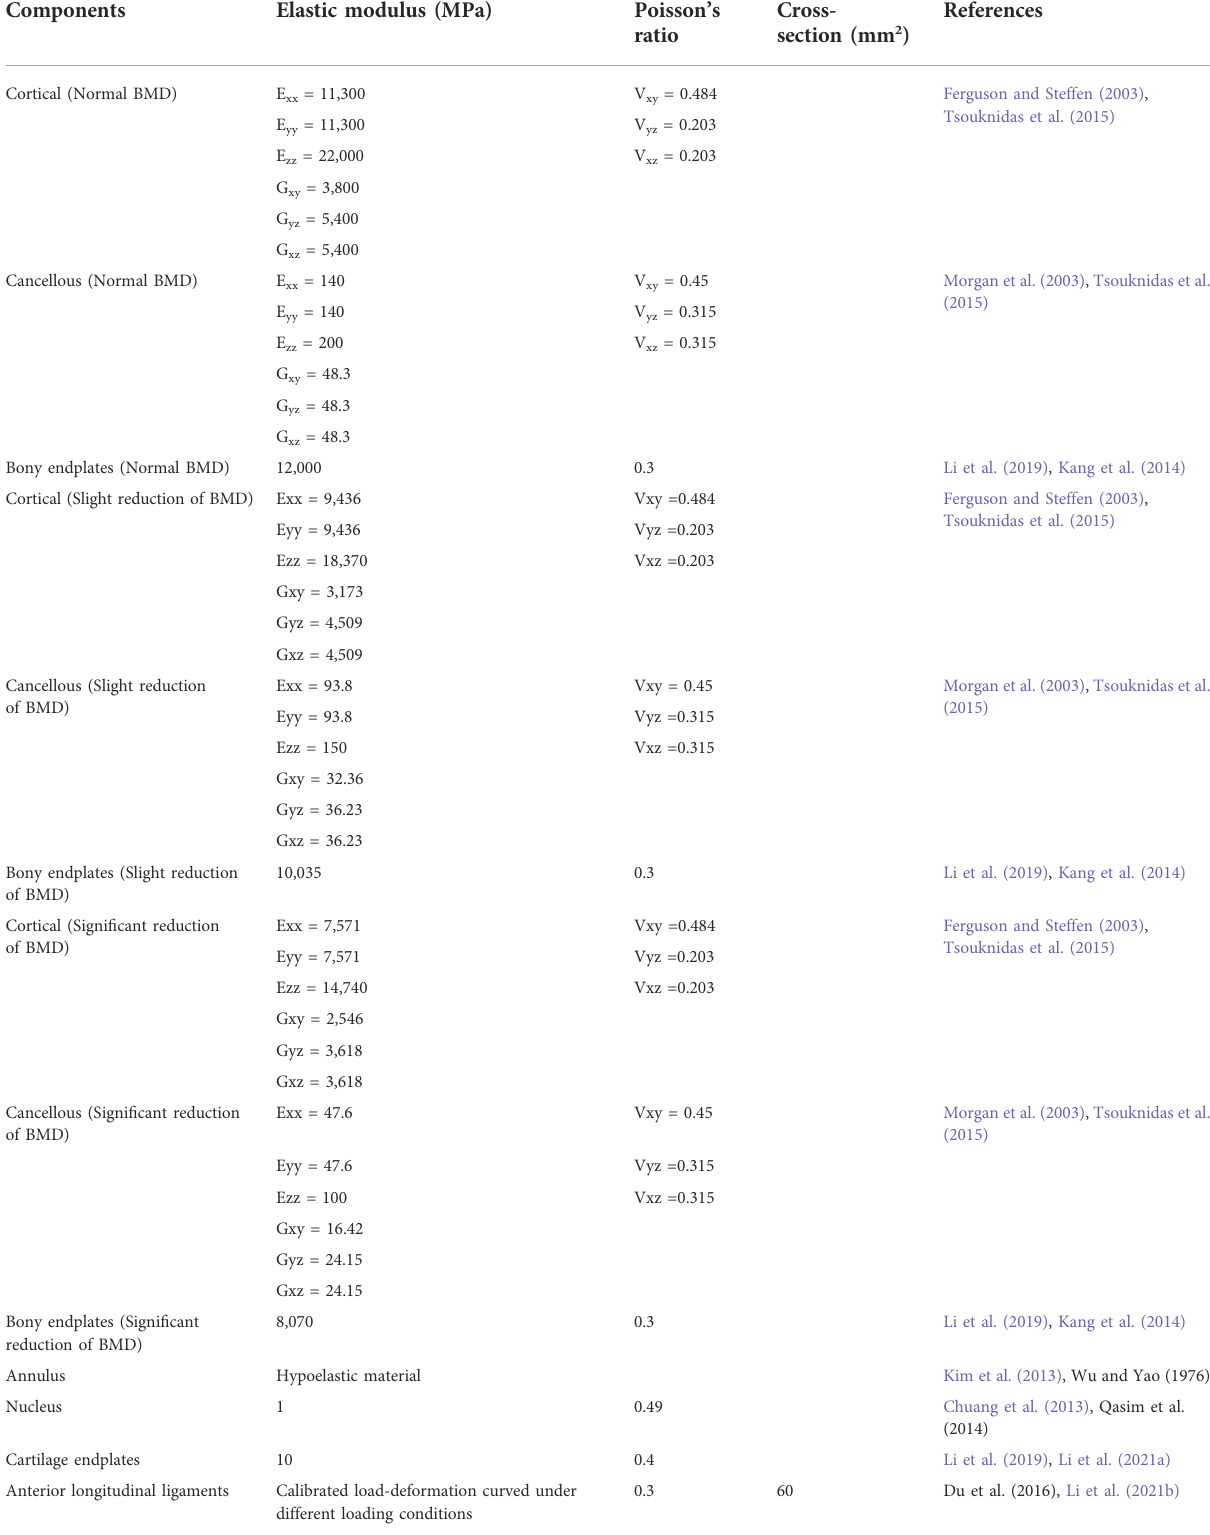
TABLE 1 Material properties of FE models ’